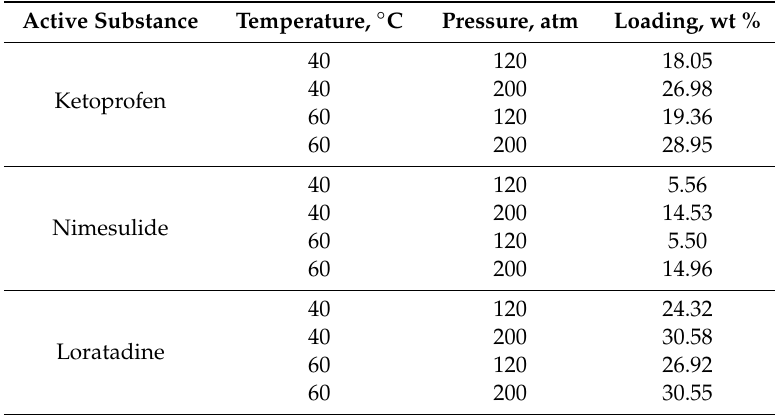
Table 3. Results of adsorption